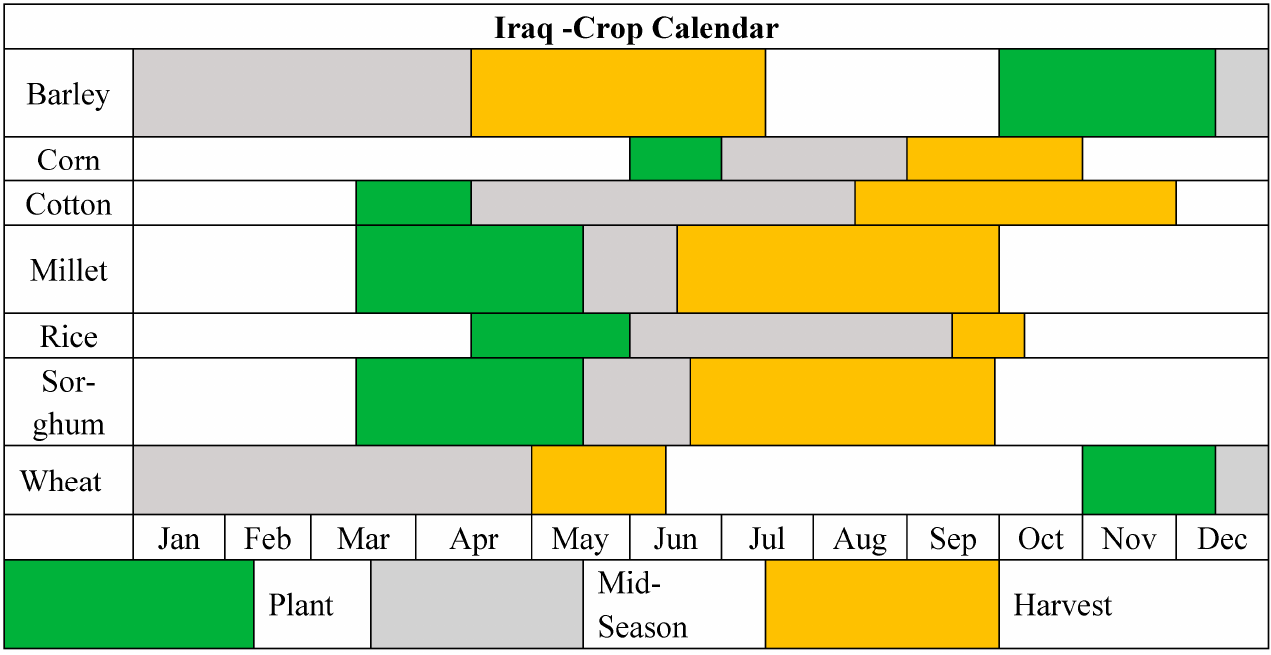
Figure 4. Crop Calendar in Iraq [7].